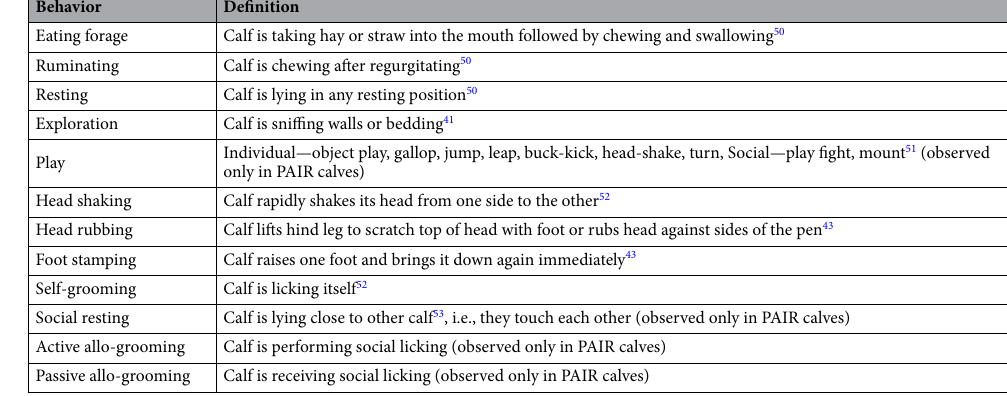
Table 1. The definition of behaviors observed in individually and pair-housed (PAIR) calves pre- and post- disbudding. The ethogram was based on the studies cited in the table.